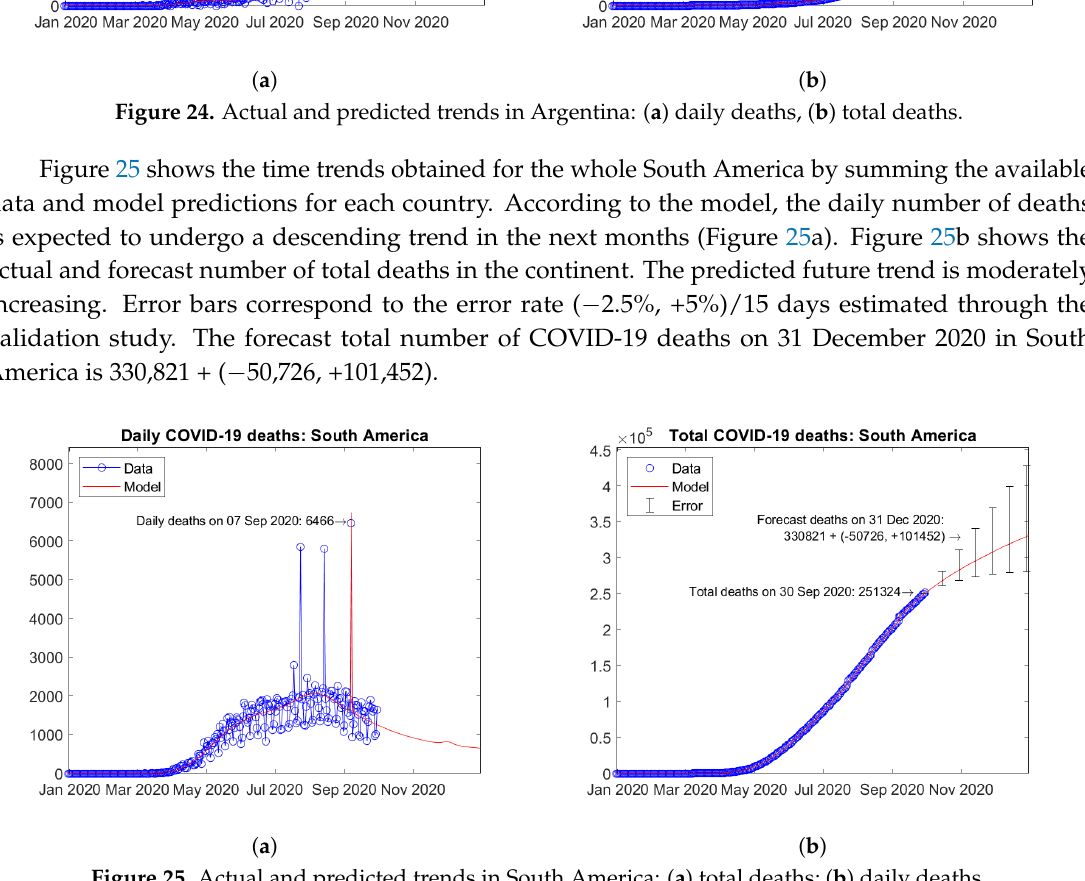
Figure 25. Actual and predicted trends in South America: ( a ) total deaths; ( b ) daily